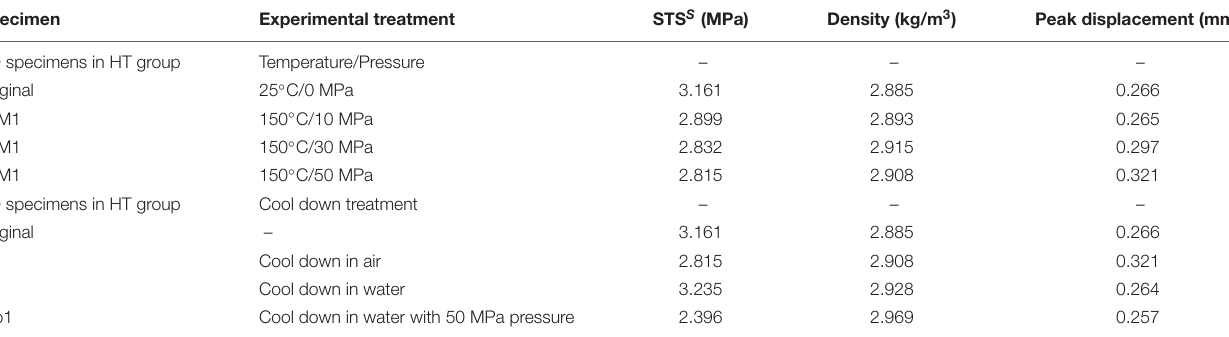
TABLE 1 | The static splitting tensile strength (STS S ), density ( ρ ), and peak displacement of treated gritstone specimens after the